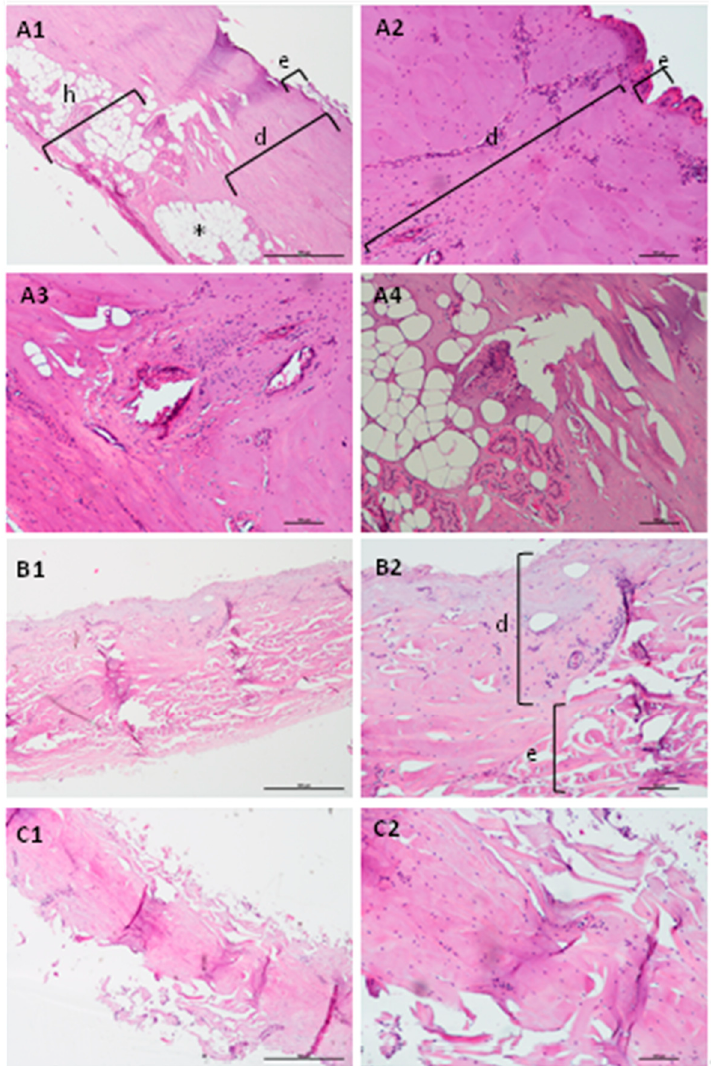
Figure 4. Histological sections of skin portions collected during the SC isolation process. ( A )—samples collected prior to trypsin digestion (0.1% w / v ) ( A1 – A4 ); ( B )—after 4 h incubation at 4 °C; ( C )—after overnight digestion. Asterisks represent vacuoles derived from adipocytes; d—dermis; e—epidermis; h-hipodermis. HE staining; Scale: A1 – C1 (4×), bar 500 µm; A2 – A4 , B2 , C2 (10×), bar 100 µm.